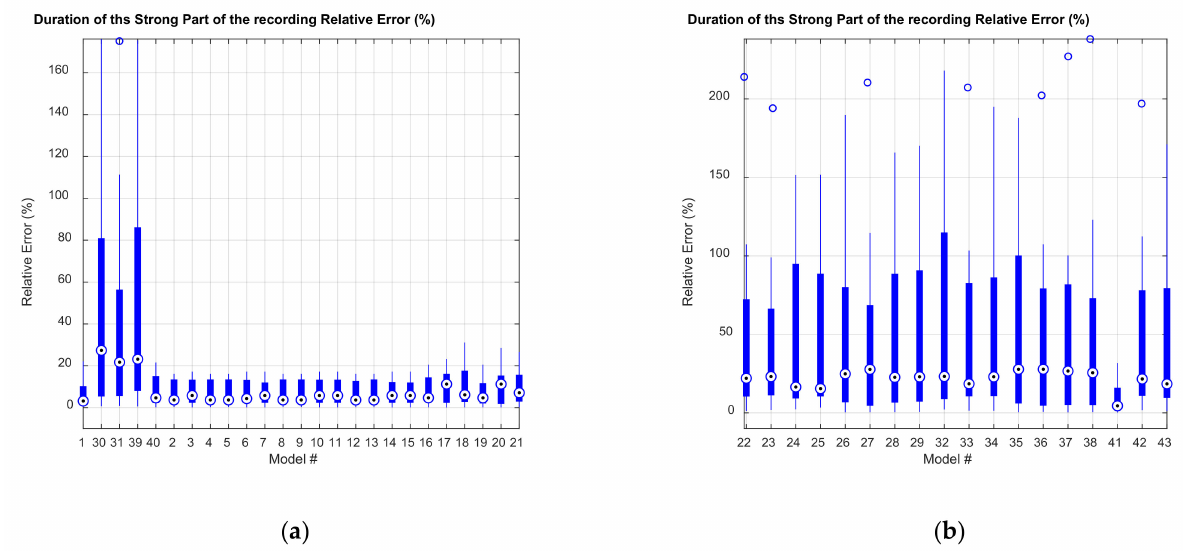
Figure 11. Median relative errors on the duration of the strong part of the signal. ( a ) Models without vertical springs at the base; ( b ) models with vertical springs at the base.